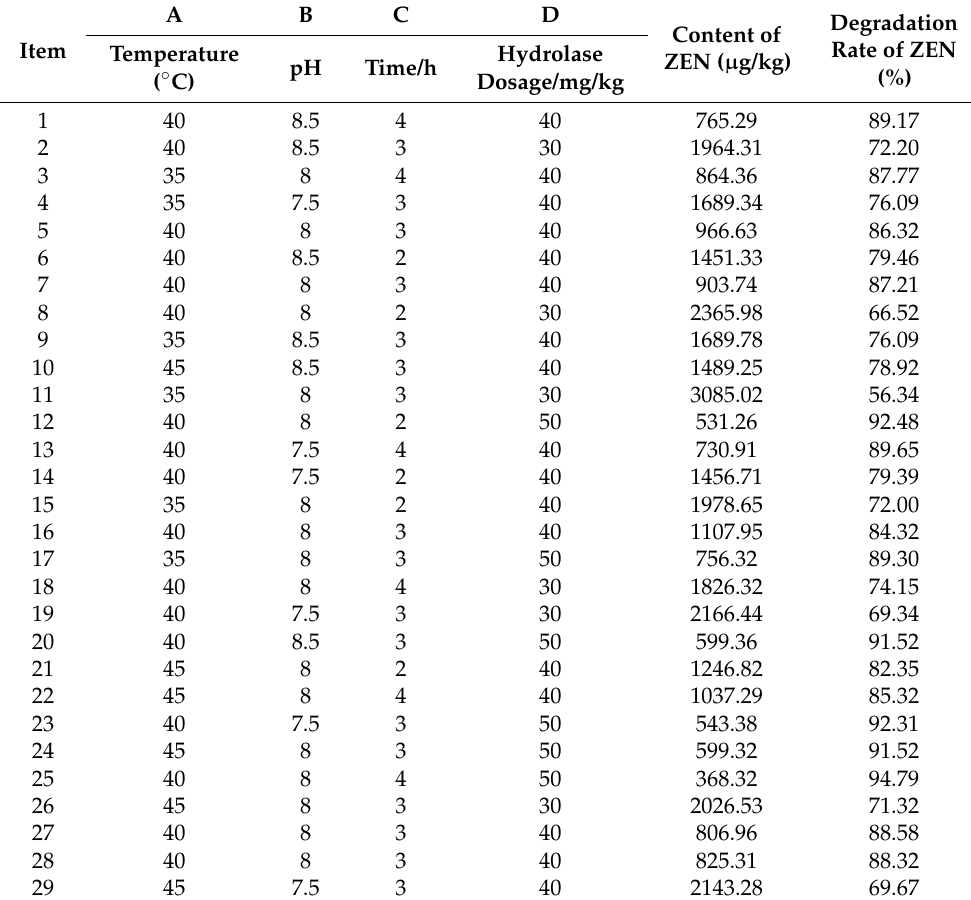
Table 1. Box-Behnken experimental design matrix and experimental results.